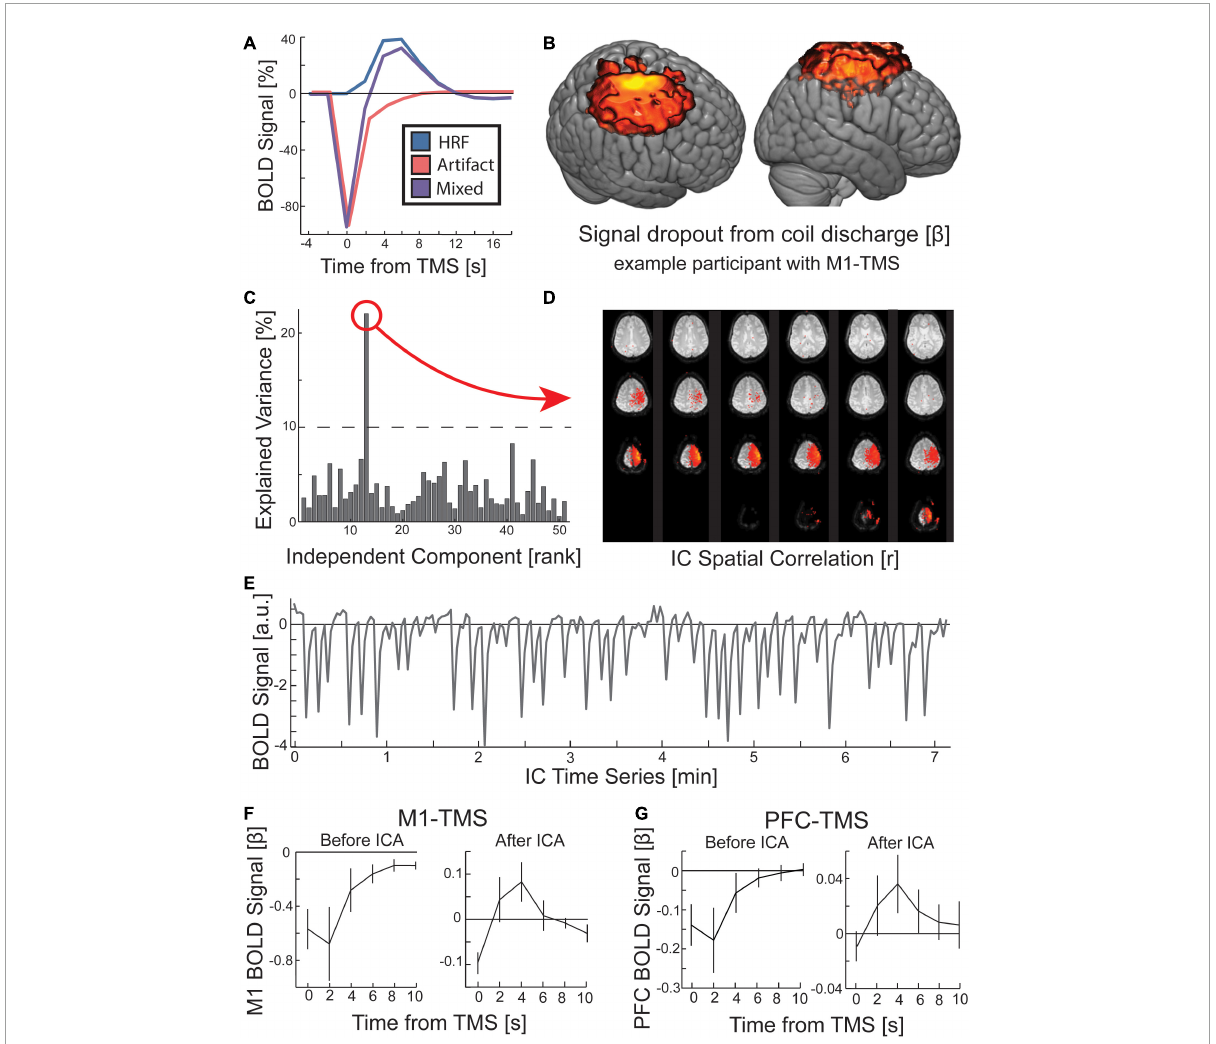
FIGURE3 Procedure for removing the local artifact of TMS coil discharge in the preprocessing of fMRI data. (A) The measured BOLD activity following TMS is a mixed signal (purple) of an immediate signal drop around the TMS coil (red) and the evoked hemodynamic response function (HRF; blue). (B) When the canonical HRF was replaced with an inverted gamma function, a GLM for all TMS conditions revealed a significant ( p < 0.00001; k > 1000) signal dropout at the location targeted by TMS and rising out of the scalp into the location of the TMS coil. While displayed with hot colors, this activity reflects a signal drop centered on the time of TMS. (C) ICA identified the TMS coil discharge artifact. GLM identified IC time course that correlated with the predicted coil artifact (threshold at 10% explained variance). The (D) spatial correlation and (E) time course of a TMS coil artifact IC are depicted. (F,G) Across all participants, the TMS coil artifact was present prior to ICA, but the HRF was visible after ICA rejection. Error bars are